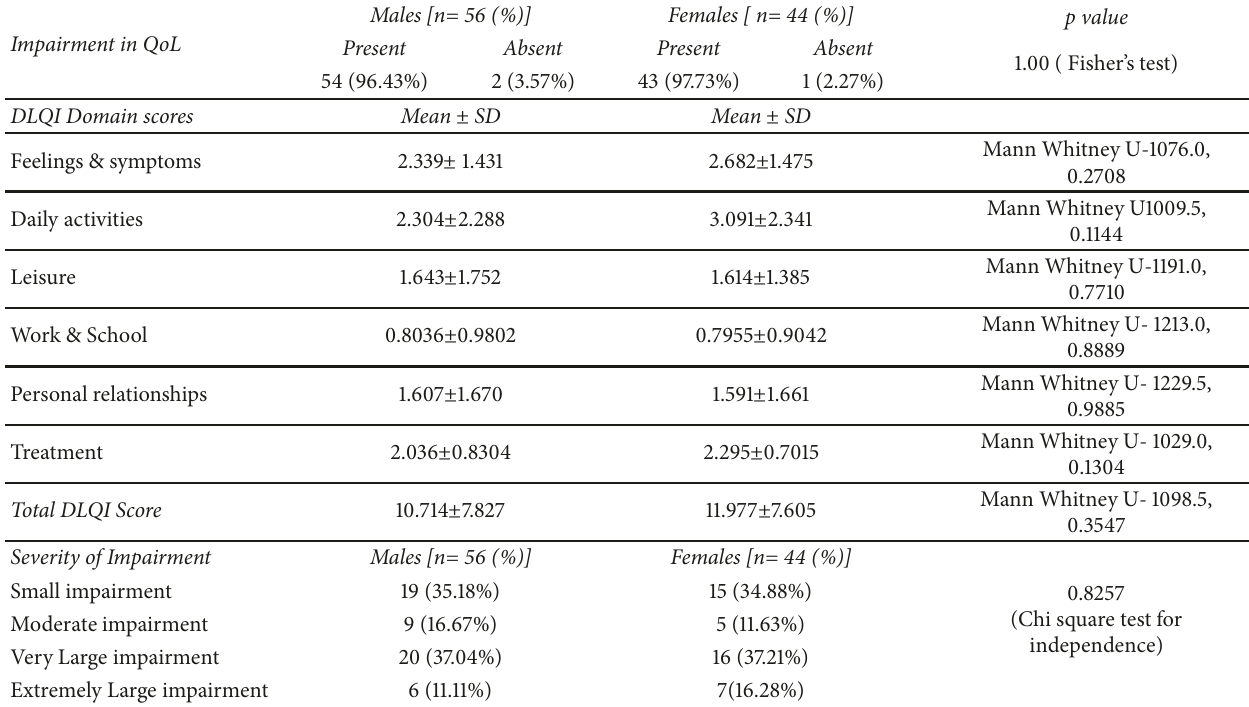
Table 5: Prevalence and severity of impairment in quality of life (QOL) as per DLQI.